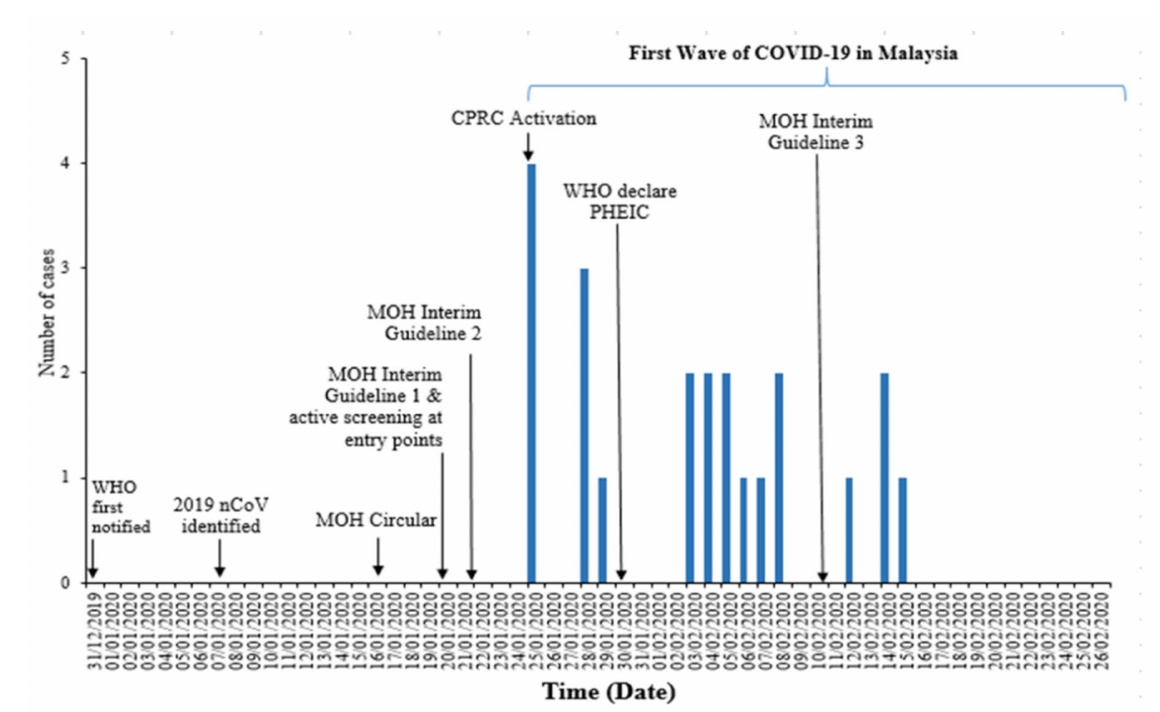
Figure 1. Epidemic curve of first wave of COVID-19 in Malaysia.